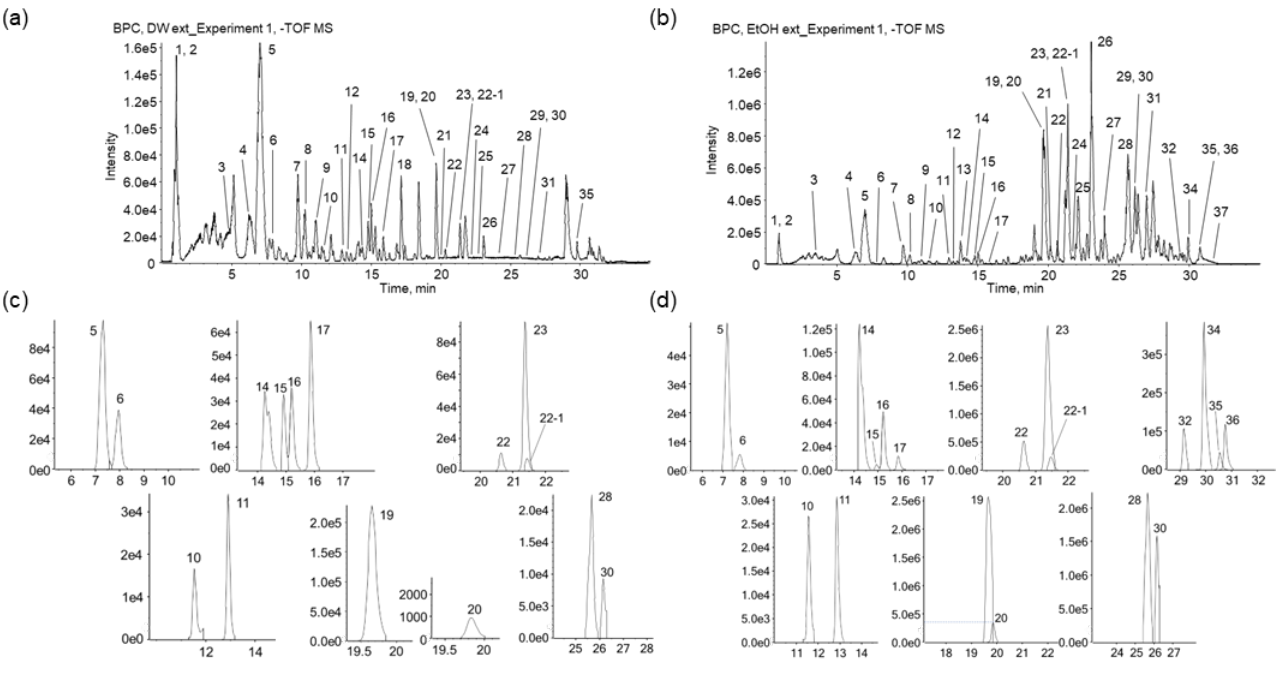
Figure 6. Chemical identification in PSY extracts. Representative BPCs of the Water-Ex ( a ) and EtOH-Ex ( b ) and expanded XICs from the Water-Ex ( c ) and EtOH-Ex ( d ) are presented. The scale of Y axis for intensity (CPS) on the chromatograms indicate that 1.6e5 equals 1.6×10 5 . Quinic acid (peak 2 ) was identified using molecular networking (MN) analysis through Global Natural Products Social Molecular Networking (GNPS), and its derivatives, neochloro- genic acid ( 3 ), chlorogenic acid ( 5 ), cryptochlorogenic acid ( 6 ), 1,4-dicaffeoylquinic acid ( 15 ), 1,3-dicaffeoylquinic acid ( 16 ), and 4,5-dicaffeoylquinic acid ( 17 ), were identified